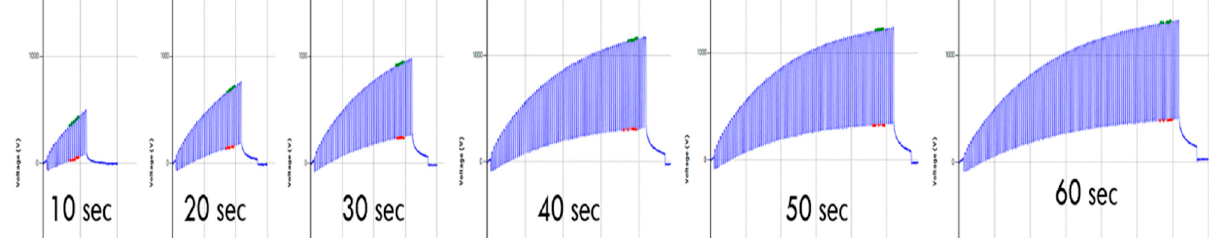
Figure 8. Time duration effect on electrostatic waveform to get a saturation point.